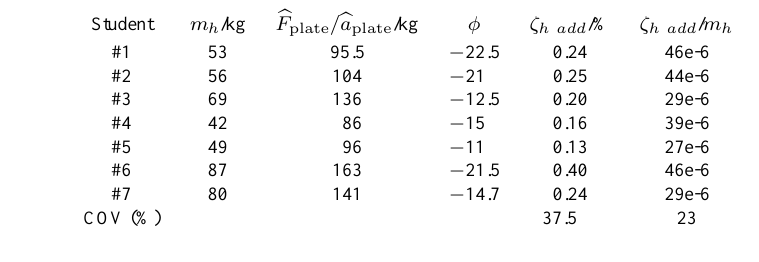
Table 2 Damping and energy dissipation parameters for seven students